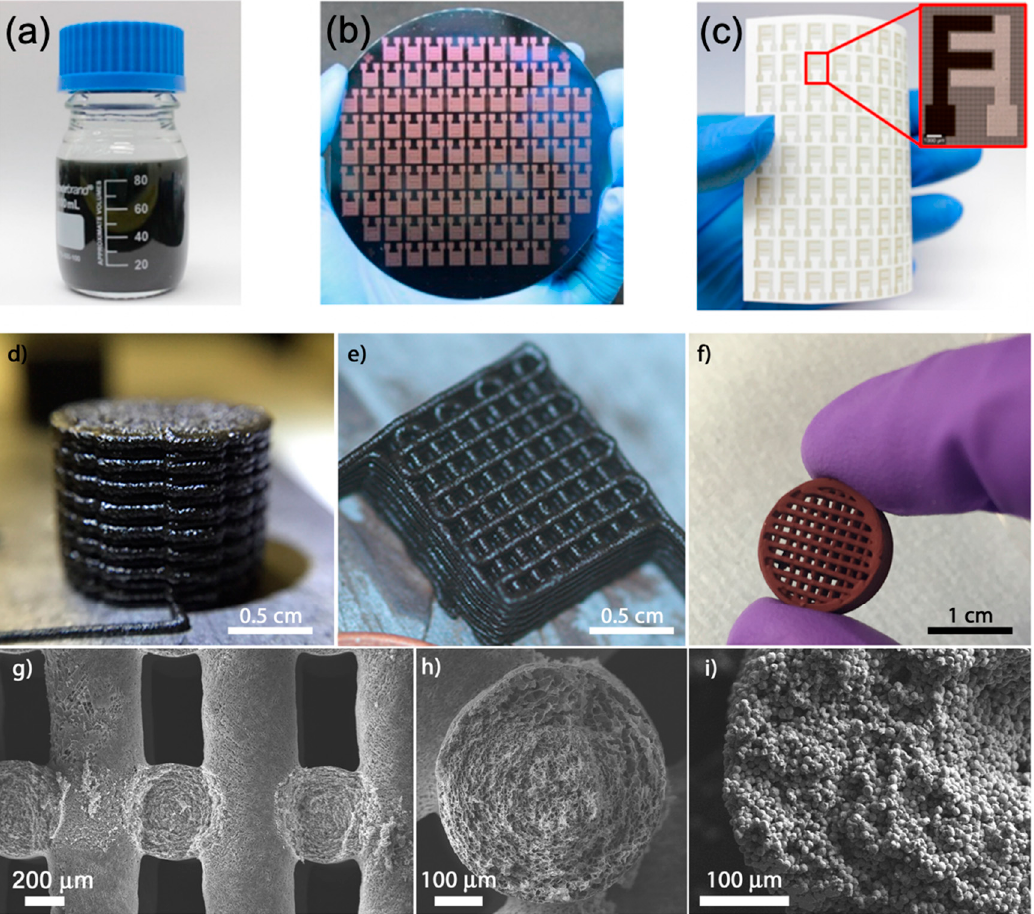
Figure 10. ( a ) c-MoS 2 ink. ( b ) 96 inkjet-printed interdigital 3D 1T c-MoS 2 MSCs on a 4 in. Si wafer. ( c ) 96 inkjet-printed 3D 1T c-MoS2/rGO based AMSCs on flexible photopaper. Inset: Optical microscopic image of a single AMSC. Adapted from ref. [83]. ( d – i ) Images of the structures from Graphene-Based electrodes for electrochemical storage after 3D printing made by Rocha et al. [148] (adapted from ref. [148]).